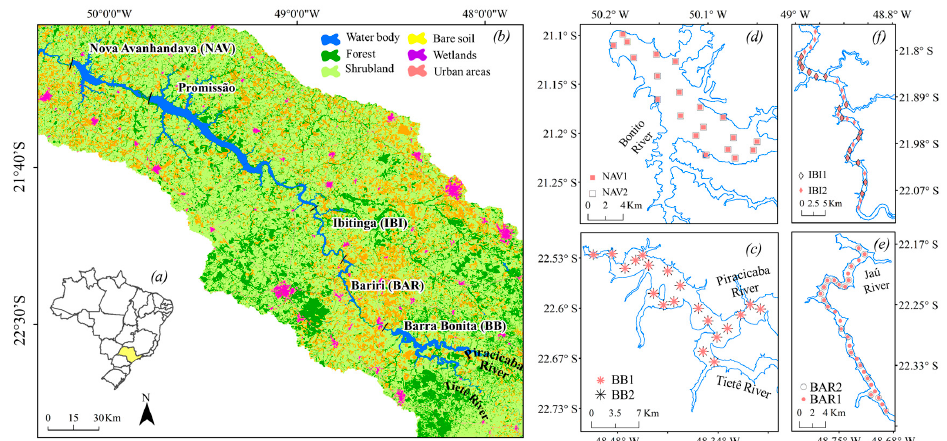
Figure 1. Brazil with S ã o Paulo State location ( a ); Map of the Tiet ê River Cascade System of Reservoirs (TCSR) and respective Land cover classes of Tiet ê basin (water body, forest, shrubland, bare soil, umid areas and urban areas by CPLA, 2010) ( b ); and sampling locations were detailed for each reservoir Barra Bonita ( c ); Nova Avanhandava ( d ); Bariri ( e ); Ibitinga ( f